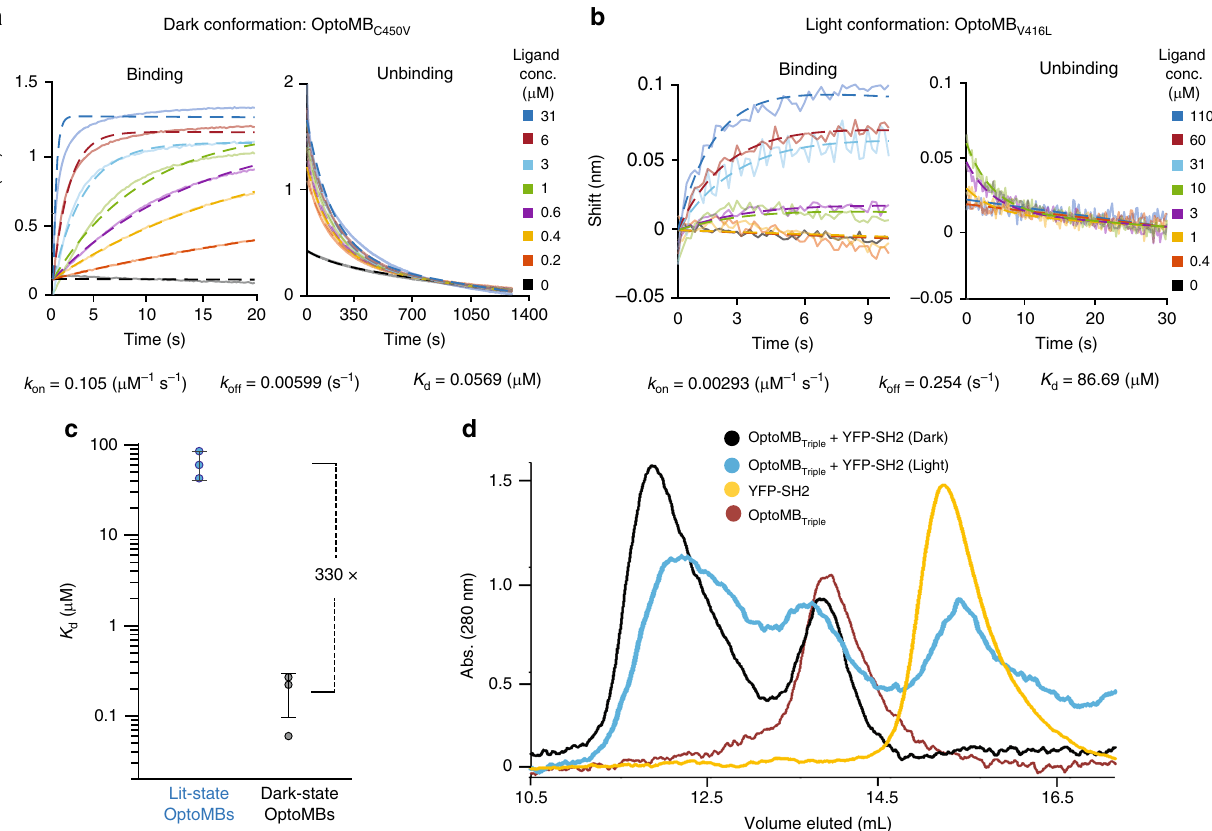
Fig. 3 OptoMB binding kinetics and SEC pro fi le for lit and dark states. a , b Representative BLI measurements of binding (left) and unbinding (right) of YFP-SH2 to immobilized OptoMB. a Dark-state measurement using the light-insensitive OptoMB C450V , and no external light source. b Lit-state measurement using the lit-stabilized OptoMB V416L and exposing the sample to light. The calculated rate ( k on , k off ) and dissociation ( K d ) constants are shown below the BLI data. c Change in calculated K d values between all dark-state (OptoMB C450V ) and lit-state (OptoMB V416L ) measurements. Error bars indicate mean ± SD for n = 3 independent measurements (see Table 1). d Size exclusion chromatography pro fi les of SUMO-tagged OptoMB V416I_G528A_N538E (OptoMB Triple ) and YFP-SH2 interactions in light (blue line) and dark (black line), compared to pure OptoMB Triple (red) or YFP- SH2 (yellow) controls. Source data are provided as a Source Data fi le.